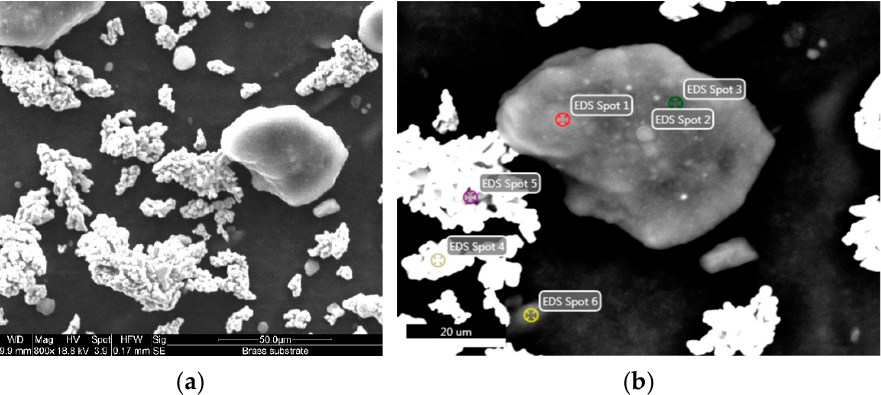
Figure 8. SEM of Cu particles and graphene aggregates in Cu-Gr powder mixture. ( a ) magnificaton 800×, ( b ) magnification 2000×; the EDS spots are shown. Table 2. EDX of Cu-Graphene powder mixture. Spot Number Element